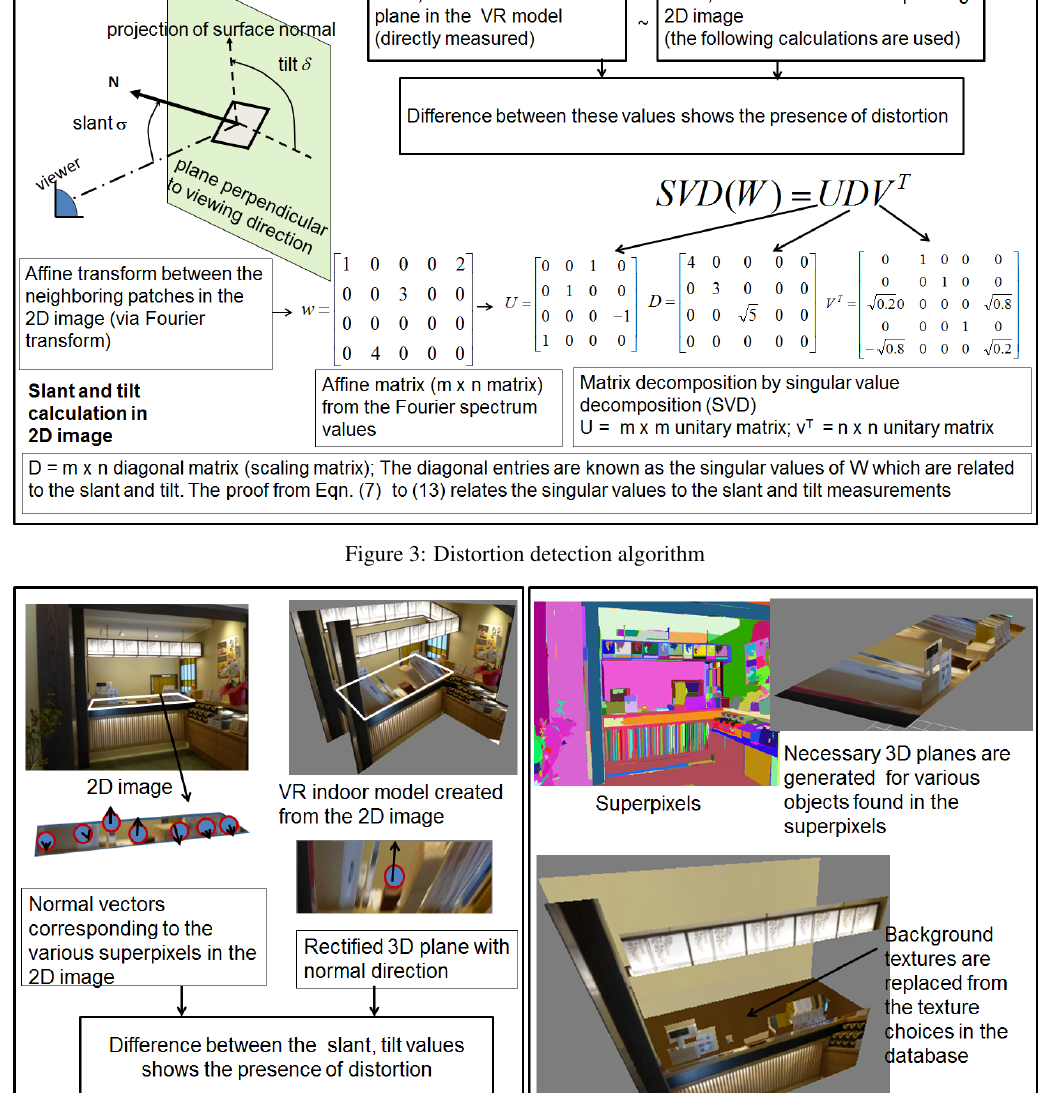
Figure 4: Virtualized reality indoor model and distortion